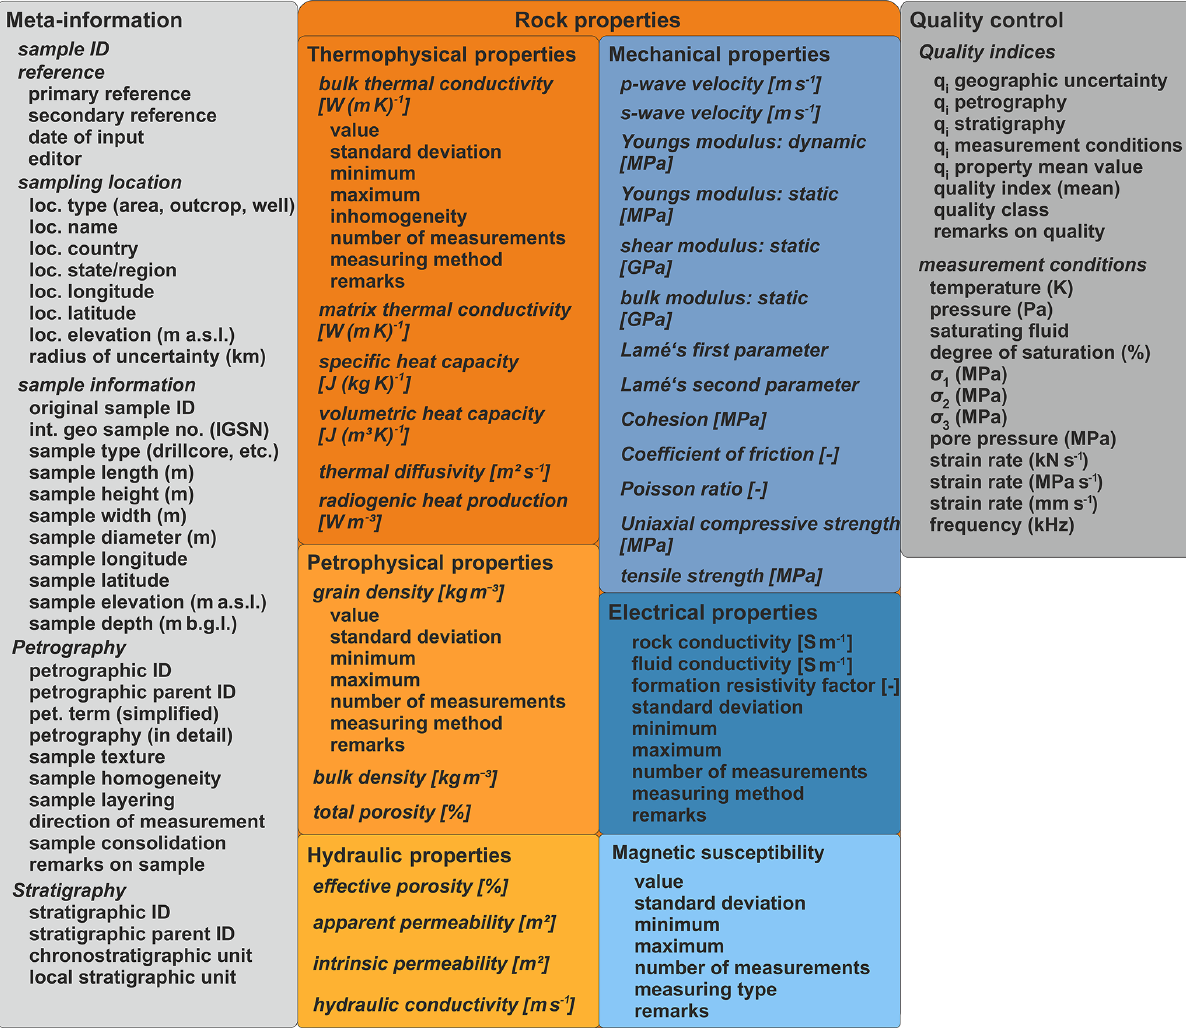
Figure 2. Schematic structure of P 3 illustrating the three sections or super-entities: meta-information, rock properties and quality control. Different input parameters (small font) are grouped according to the entities or property sub-tables (italics) they belong